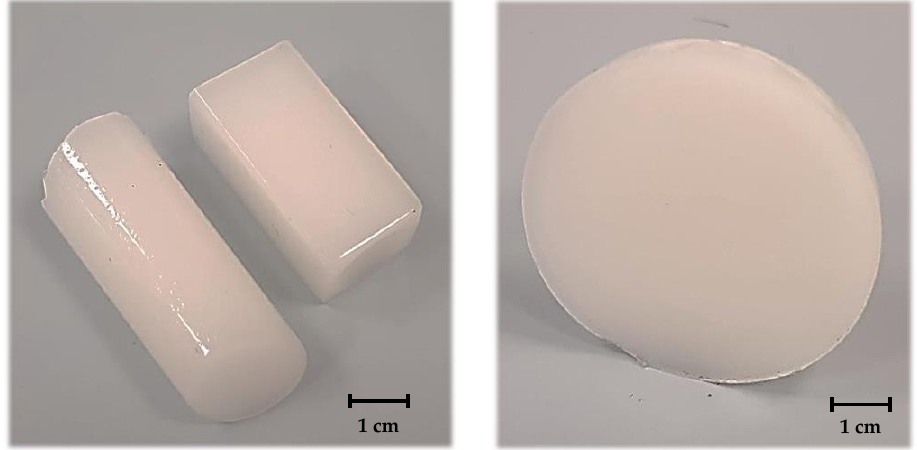
Figure 11. Various shapes of prepared ceramic-polymer